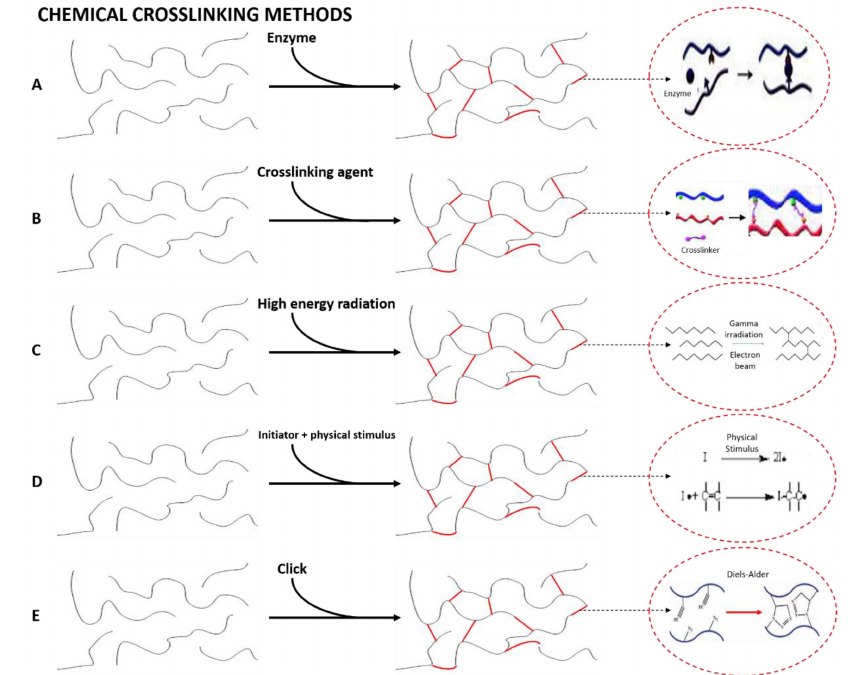
Figure 5. Formation of chemically cross-linked hydrogels by ( A ) enzymatic reactions, ( B ) chemical reaction promoted by a cross-linking agent, ( C ) high-energy radiation, ( D ) free-radical polymerization and ( E ) click